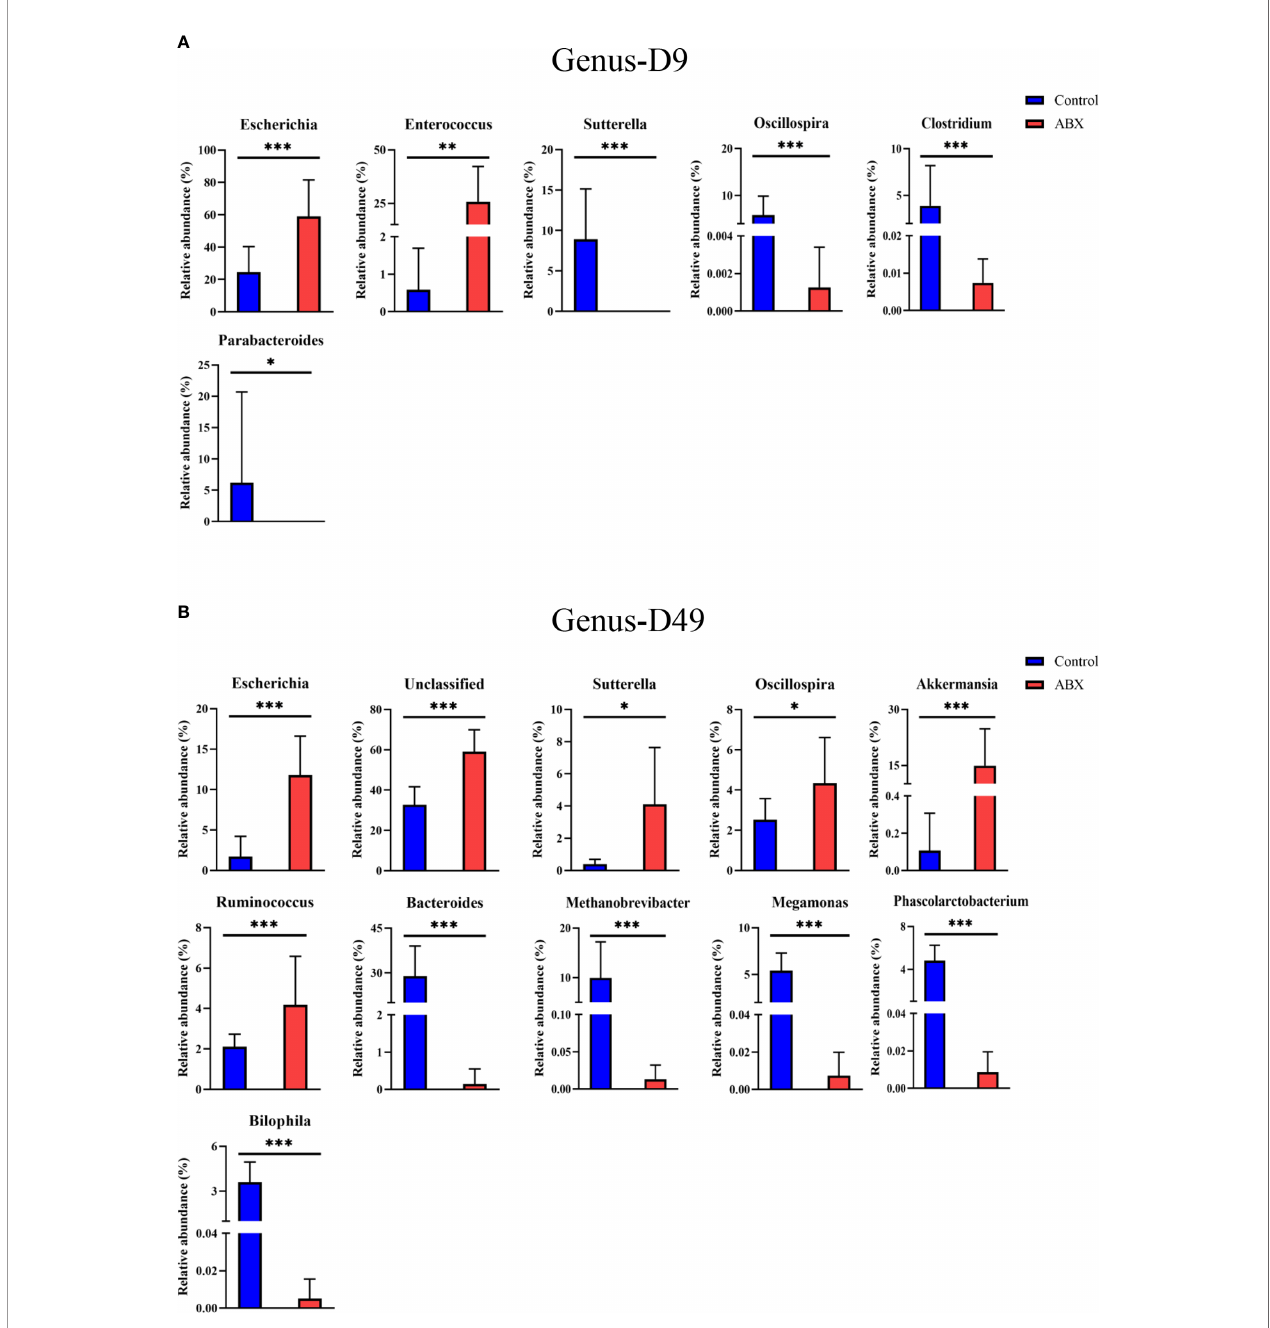
FIGURE 6 | Gut microbiota showing signi fi cant changes in relative abundance at the phylum and genus level in response to antibiotic treatment during early life. (A) Differences between the controls (Ctr) and antibiotic-treated birds (ABX) in phyla on day 9. (B) Differences in genera. * p < 0.05, ** p < 0.01, *** p < 0.001; Wilcoxon rank-sum test. n ≥ 8 for each